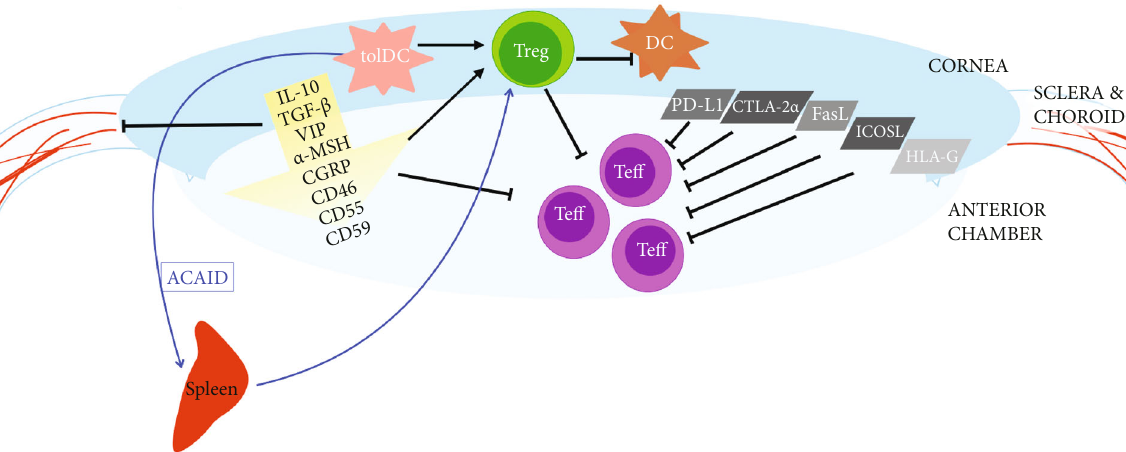
Figure 1: Mechanisms of immune privilege in the eye. tolDC: tolerogenic dendritic cell; Treg: T regulatory cell; DC: dendritic cell; Te ff : e ff ector T cell; IL-10: interleukin 10; TGF- β : transforming growth factor β ; VIP: vasoactive intestinal peptide; α -MSH: α melanocyte- stimulating hormone; CGRP: calcitonin gene-related peptide; PD-L1: programmed death ligand 1; CTLA-2 α : cytotoxic T lymphocyte- associated antigen-2 α ; FasL: Fas ligand; ICOSL: inducible costimulatory molecule ligand; HLA-G: human leukocyte antigen G; ACAID: anterior chamber-associated immune